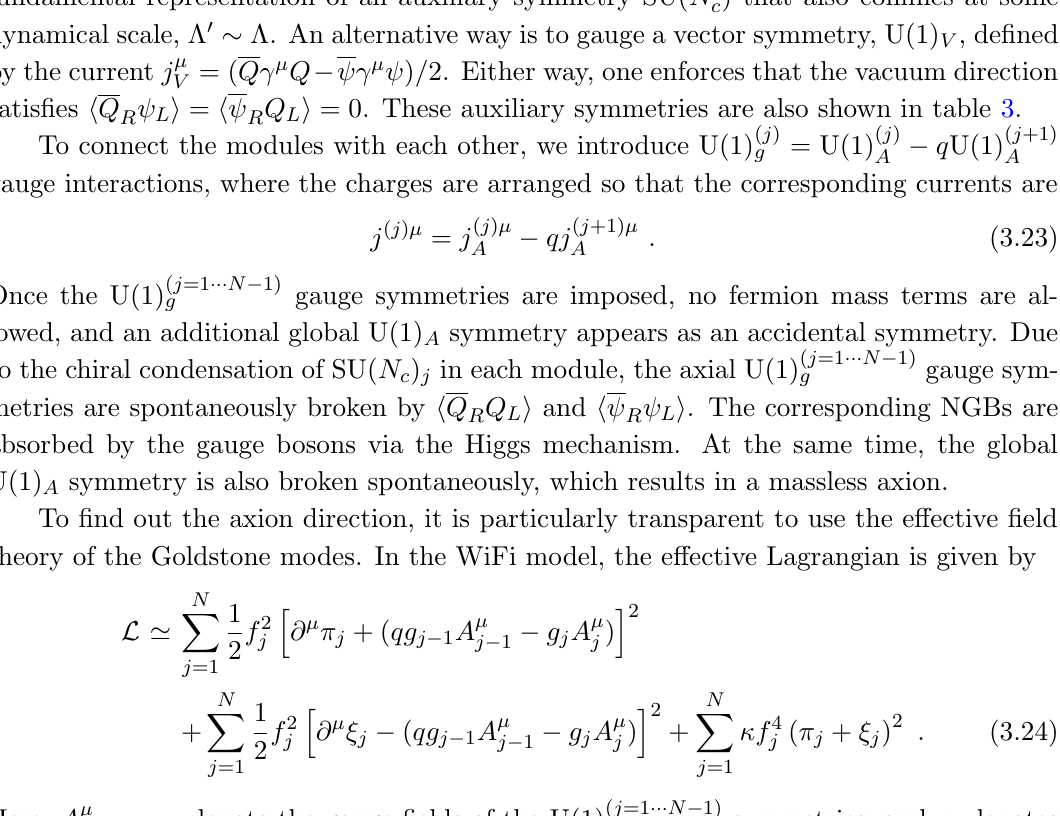
(cid:0) q U(1) ( j ) . j +1 A ) j and U(1) ( j ) , which forbid Q j j c V